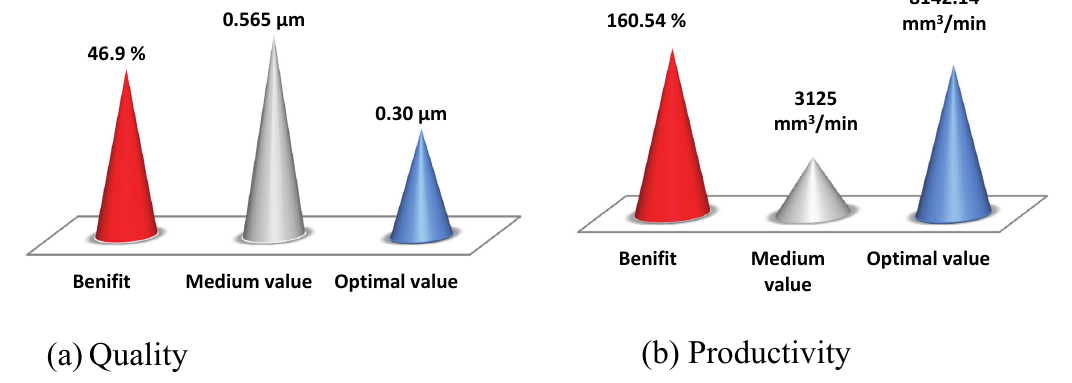
Fig. 14. (a) Improvement in surface quality and (b) industrial benefit in